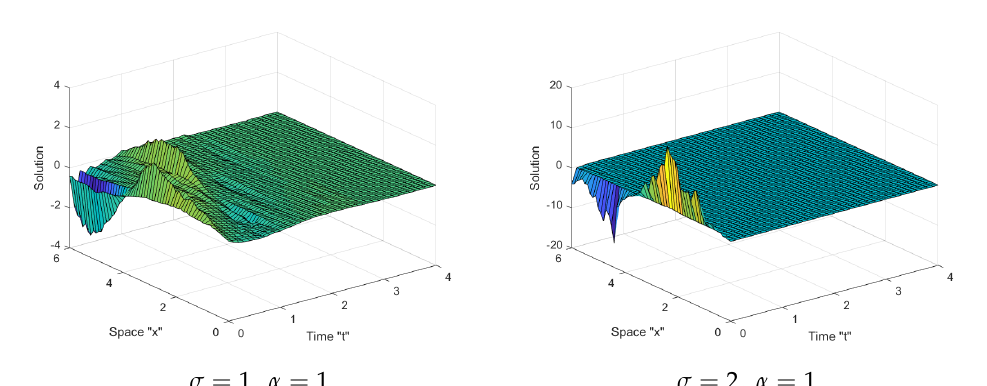
Figure 3. 3D graphs of the solution (31) with α =